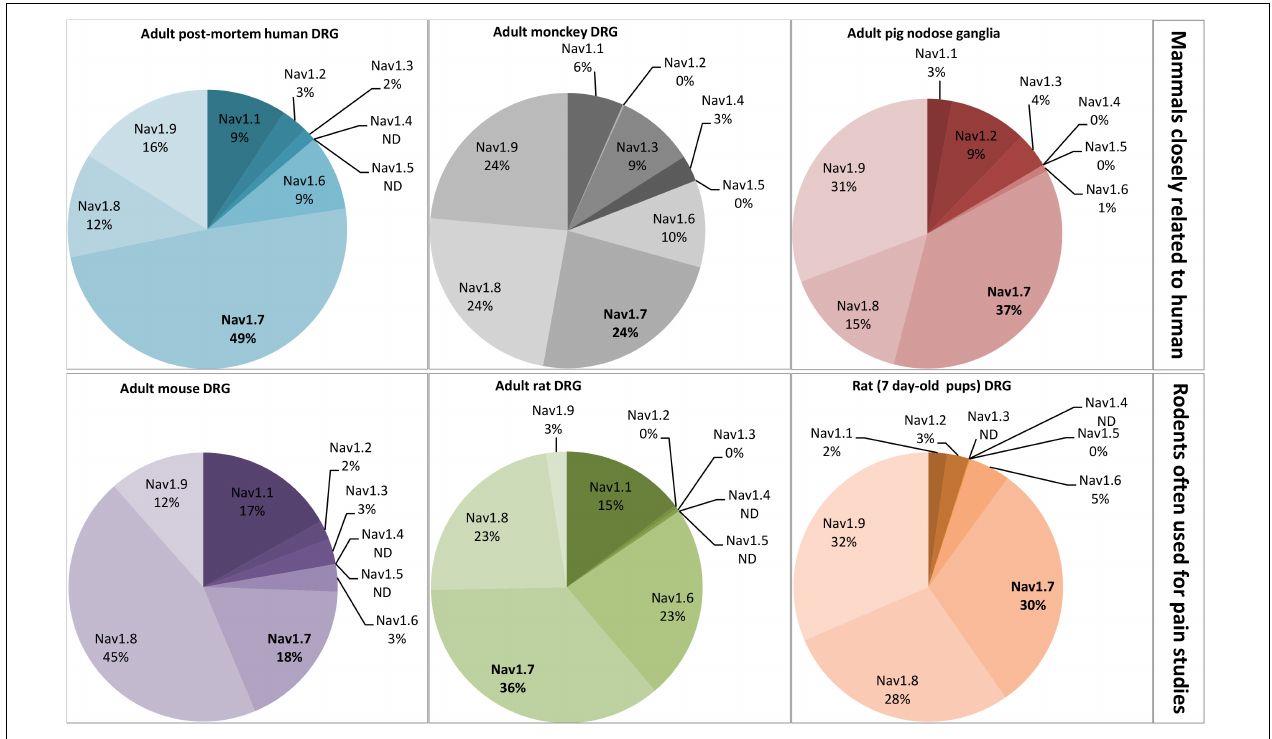
FIGURE 4 | Relative proportion of Na V channel α -subunits detected in mammalian dorsal root ganglia (DRG) neurons by RT-PCR. DRG neurons are from some representative mammals of different orders reported in the literature: primates, artyodactyla and rodents. The first order, including human and monkey, is closely related to the pig, belonging to the second order. The rodents, more distant from the human, represent the model often used for pain studies. The adult post-mortem human DRG neurons were obtained from healthy donors. All the data are from DRG neurons of adult mammals except those from 7 day-old rats. ND, non-determined. Adapted from Raymond et al. (2004), Berta et al. (2008), Ho and O’Leary (2011), Muroi and Undem (2014), and Chang et al.